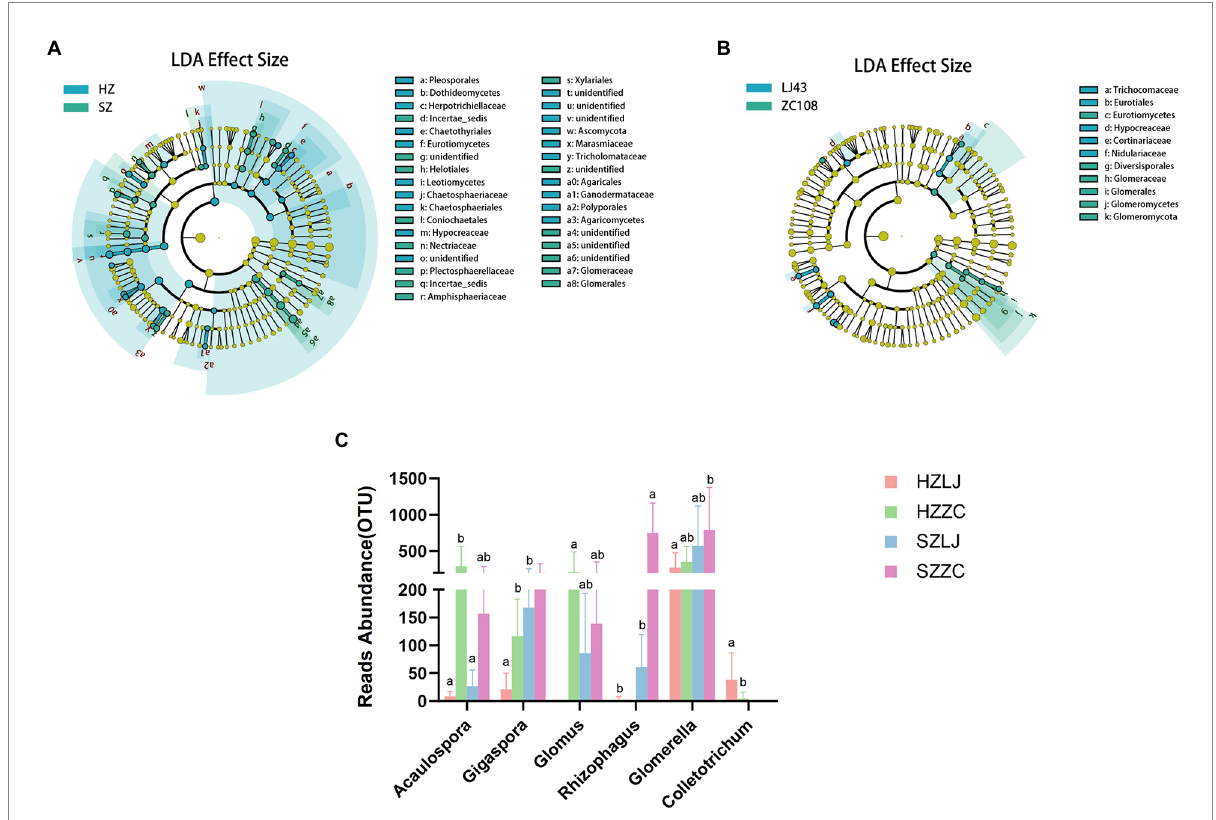
FIGURE 5 (A) LEfSe results for the different fungi in two locations, blue represents the differential fungi in Hangzhou, and green represents the differential fungi in Shengzhou ( p < 0.05, LDA>2.0). (B) LEfSe results for the different fungi in two varieties, blue represents the differential fungi in LJ43, and green represents the differential fungi in ZC108 ( p < 0.05, LDA>2.0). (C) The OTU abundance of AMF and Colletotrichum . a and b represent significance at p <